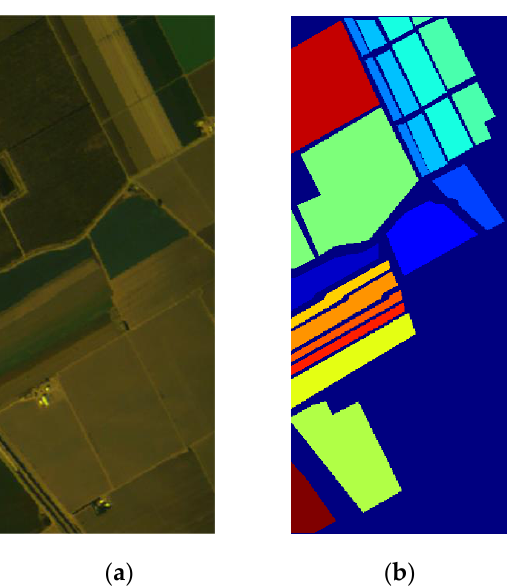
Figure 7. Pavia University dataset. ( a ) The false-color image. ( b ) The ground-truth map.